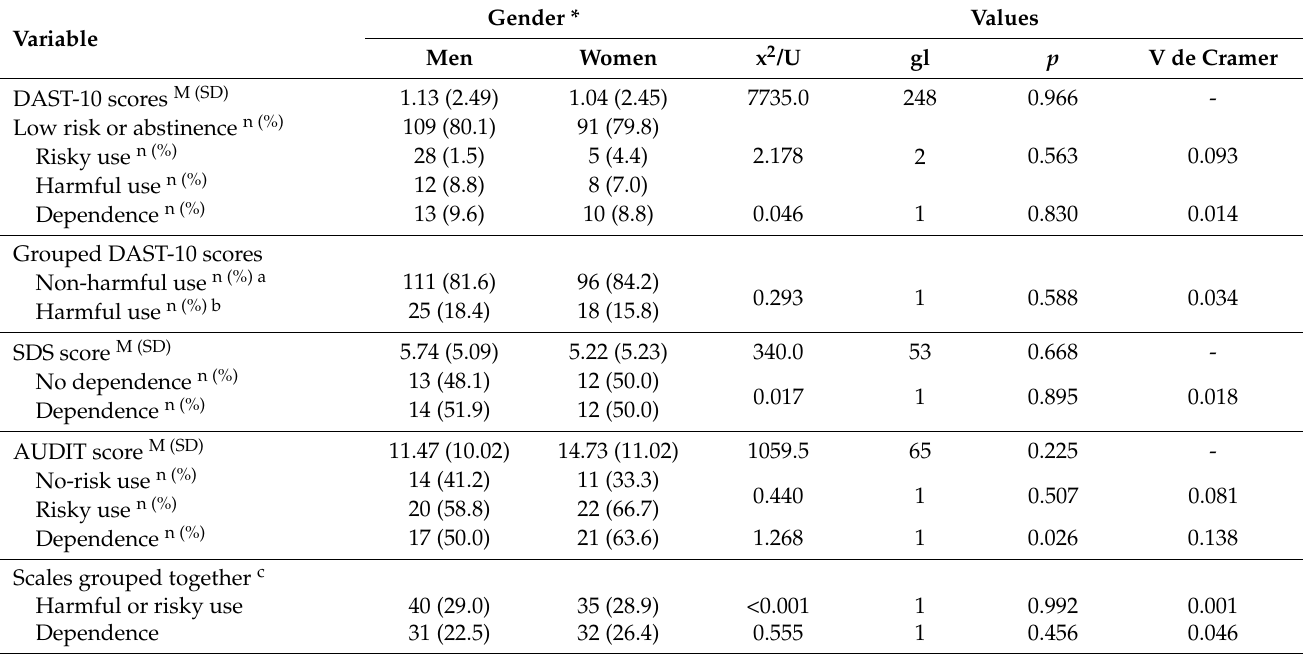
Table 4. Gender differences among PEH according to instruments for the assessment of drug and alcohol abuse and dependence (DAST-10-10, AUDIT,